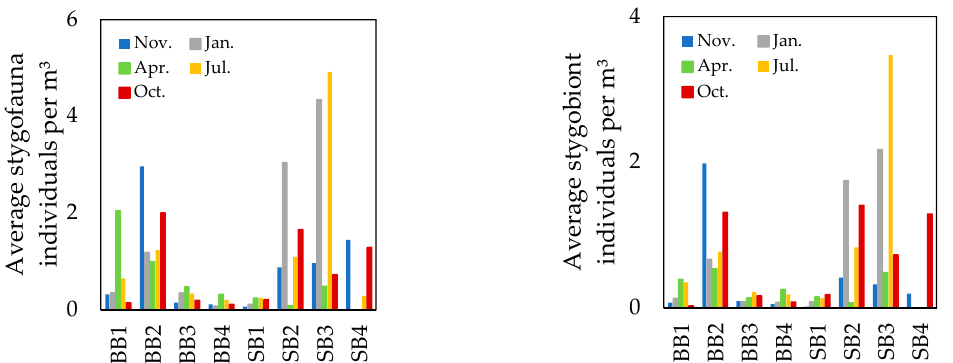
Figure 6. Average number of individuals of stygofauna (invertebrates) ( left ) and stygobites( right ) per volume (Ind./m³) for each sampled spring and sampling campaign.